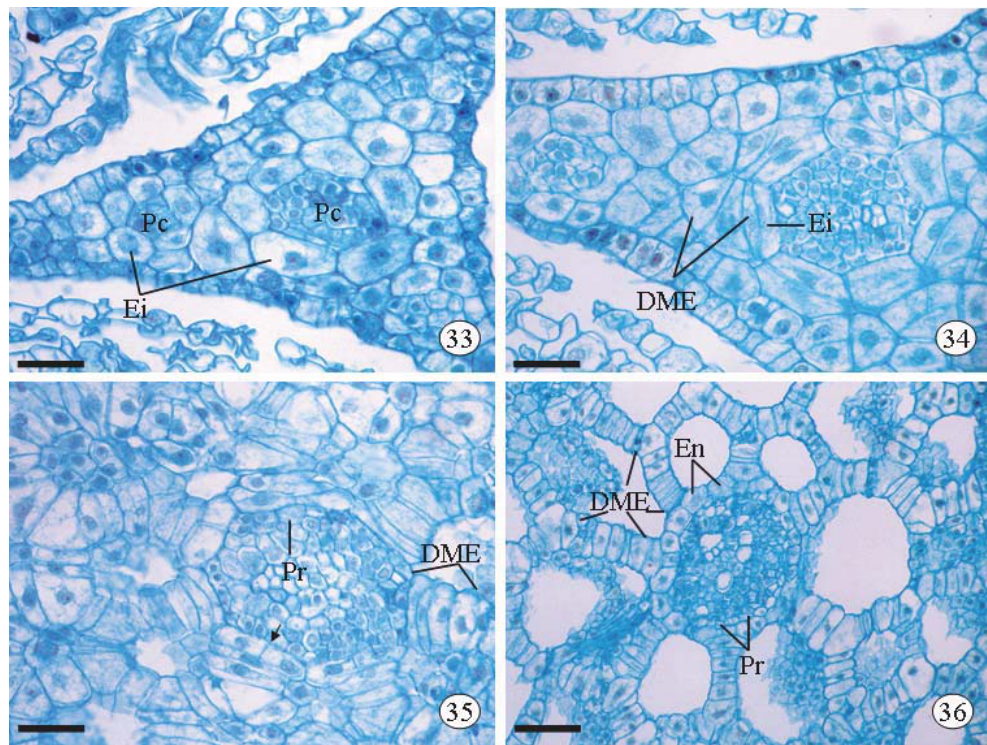
Fig. 33-36 – Echinodorus paniculatus . Leaves in differentiation, transversally cut, one showing in Fig. 33, endodermal initials (Ei) around the procambium (Pc) of each future bundle. Fig. 34 – The endodermal initials presents periclinal division and its first derivatives to comprise the DME (Derivatives of the Meristematic Endodermis). Fig. 35 – Endodermal initial presenting anticlinal division. Fig. 36 – Endodermis already undergoing differentiation, the mesophyll aerenchyma cavities being enclosed by derivatives of endodermal activity. Pr – pericycle. The bars correspond to 50 µ